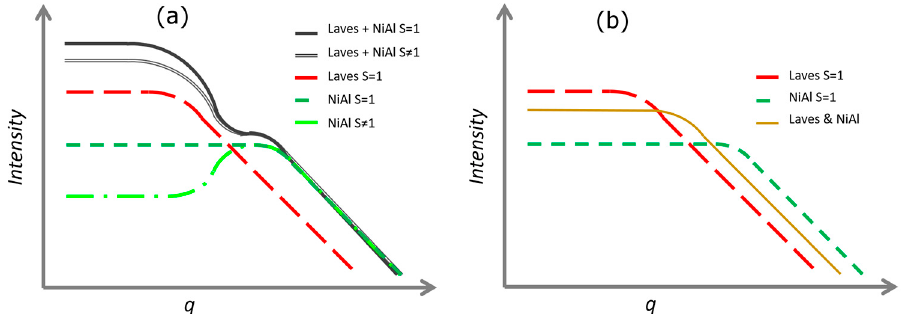
Figure A3. A schematic representation of possible contributions to the SANS results from interparticle scattering. In ( a ) it is shown how interparticle scattering between NiAl precipitates can cause a reduction in the intensity of scattering at lower q values. This would lead to an underestimation of the amount of Laves phase present; In ( b ) scattering between two phases can result in an additional scattering curve between the other two. The presence of this scattering could have a number of effects, but one of these is an overestimation in the volume fraction of NiAl.